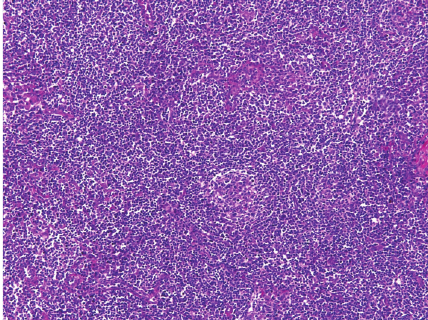
Figure 5: Hodgkin cells stained with anti-CD30 antibodies. Section of lymph node biopsy, × 400 magnification.